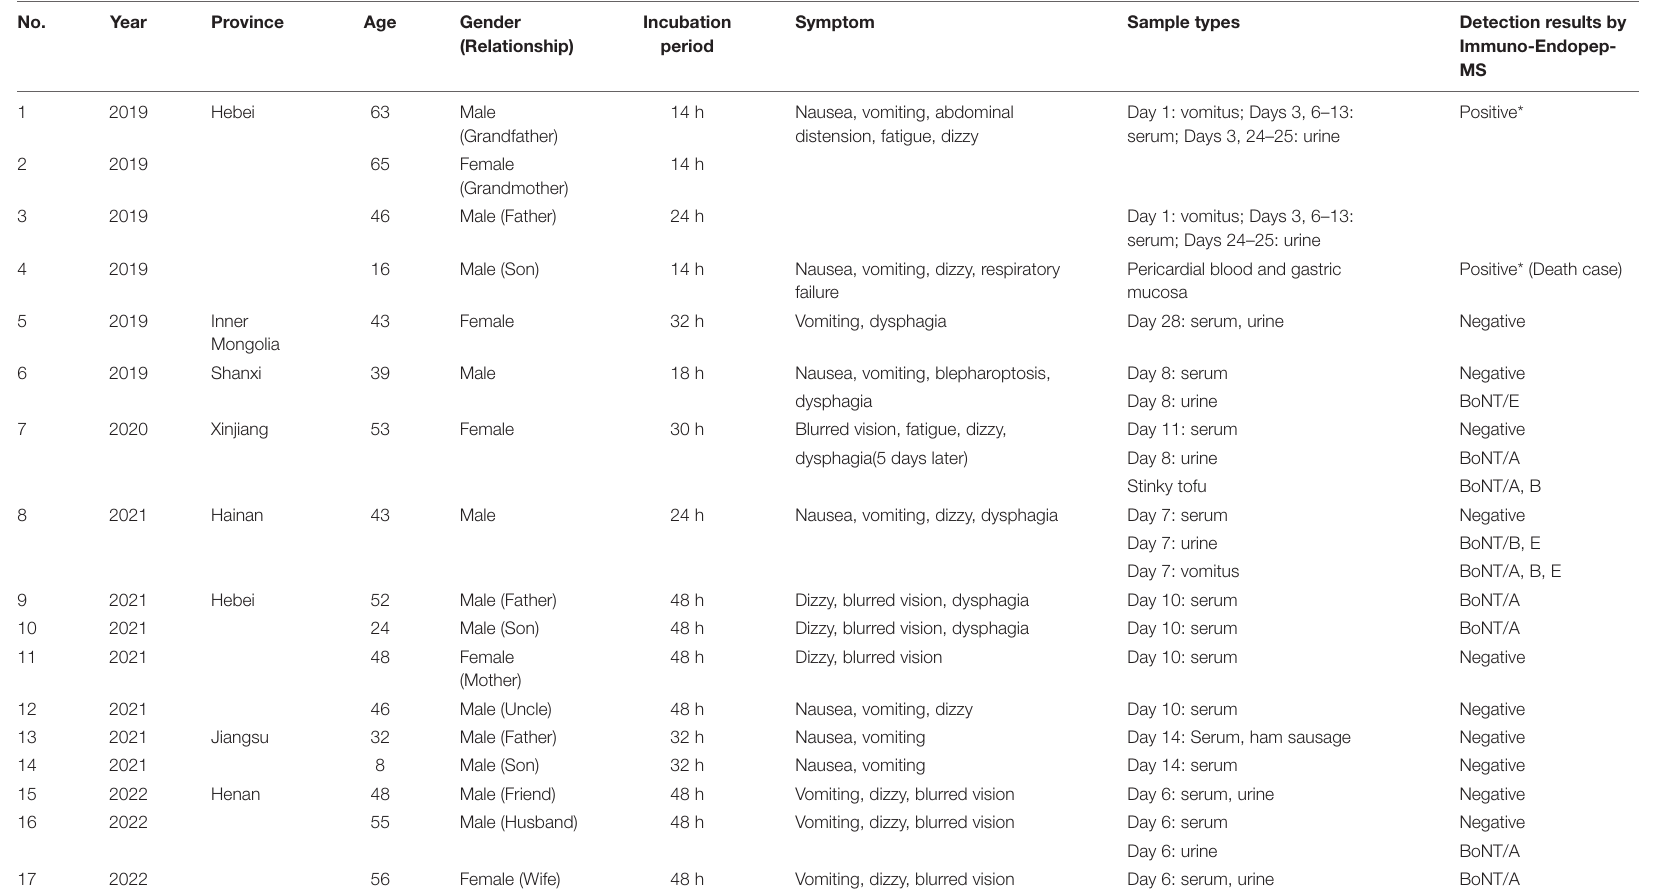
TABLE 2 | Characteristics and detection results of 17 cases of foodborne botulism from 2019 to 2022.